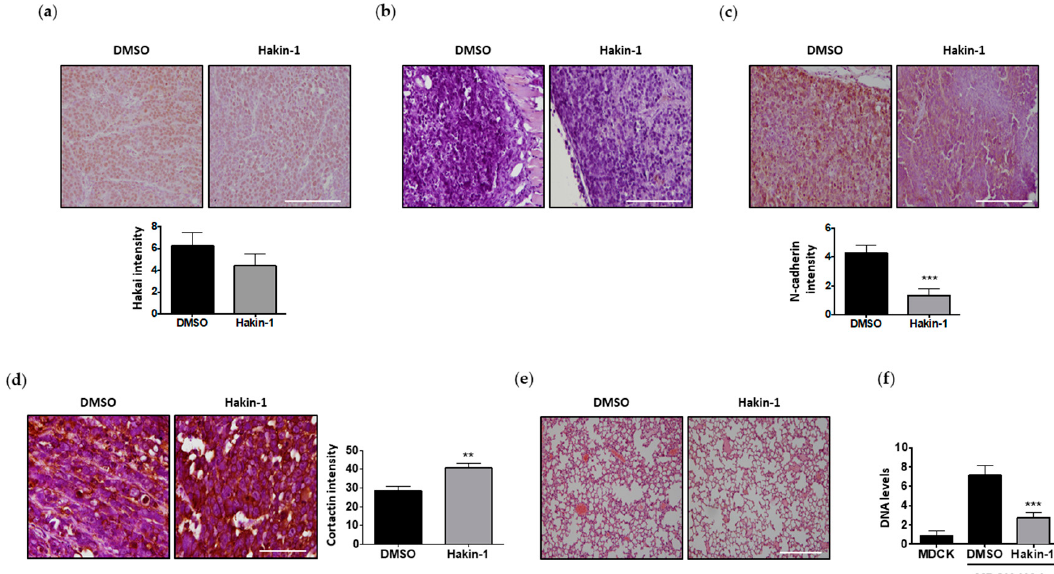
Figure 7. Hakin-1 treatment reduces mesenchymal markers of tumour xenografts and micrometastasis formation in lungs of immunosuppressed mice. ( a – c ) Immunohistochemical staining for Hakai ( a ), E-cadherin ( b ) and N-cadherin ( c ). Representative images were obtained with a 20× objective (upper panel). Quantification of significantly protein expression intensity is shown in bottom panel. ( d ) Immunohistochemical staining for cortactin and protein expression quantification is shown (left and right panels, respectively). Images were obtained with 40× objective. ( e ) H&E staining of mice lungs did not show a histological evidence of metastases. Representative images were obtained with a 10× objective. ( f ) Real-time quantitative PCR using primers for HA epitope and Hakai to detect the presence of DNA of Hakai-MDCK cells into the mice lungs. Results are expressed as mean ± SEM (*** p < 0.001). Scale bar, 500 µm.